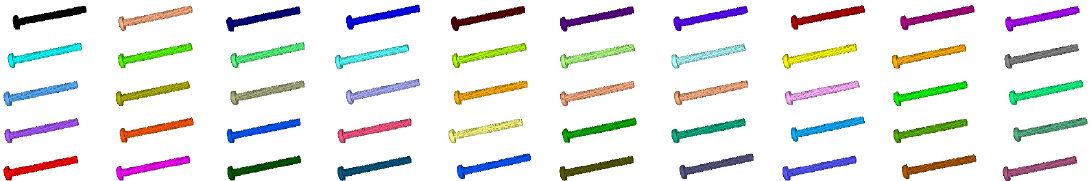
Fig. 8 Individual screws in the example in Fig. 6(a) segmented by our system. The screws are shown by placing them in evenly arranged cuboids by applying the inverse of the rigid transformation matrices also calculated by our system. Although the positions are slightly misaligned due to the positional displacements of local maximum points on the distance fields, we can find the identification of the parts is successful in terms of the well-estimated